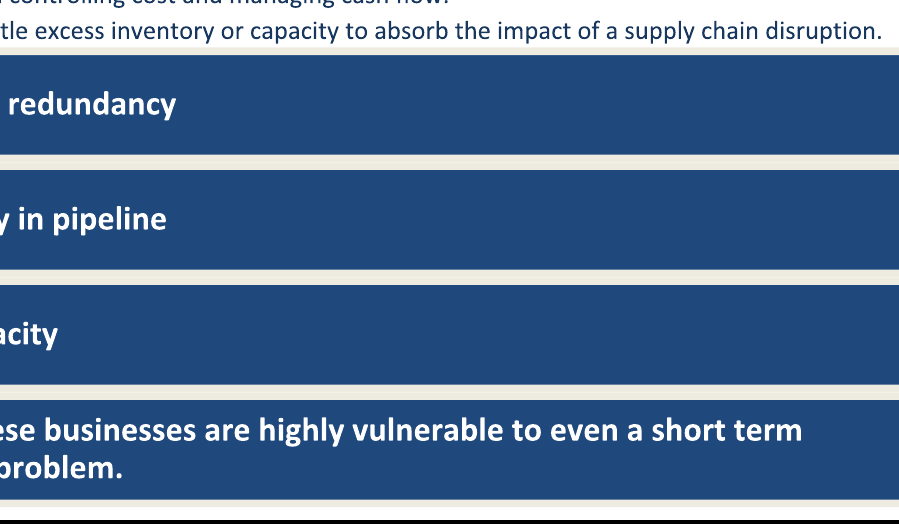
Fig. 5 Reliance on Lean Concept for Supply Chain Management. Excerpt from Sanders, N., Challenges of Vaccine Distribution and Deployment, AAPS Vaccine Stability Workshop, March 24‑25,